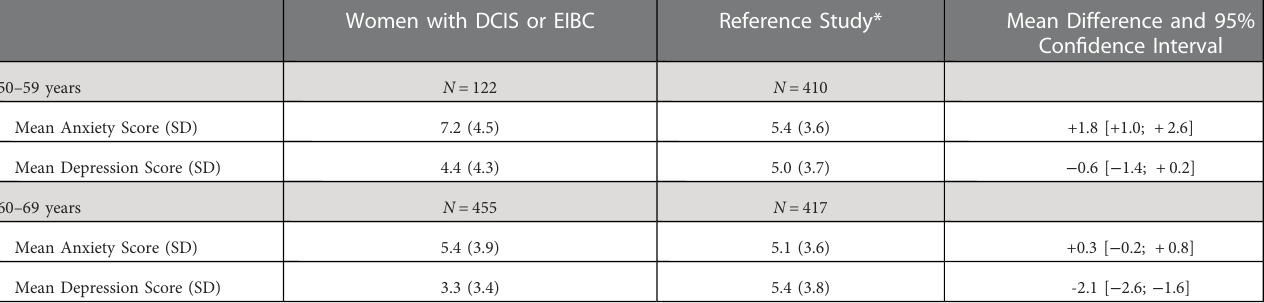
TABLE 3 Mean values (and standard deviation, SD) of hospital anxiety and depression scale (HADS) scores among women with DCIS or EIBC and the reference